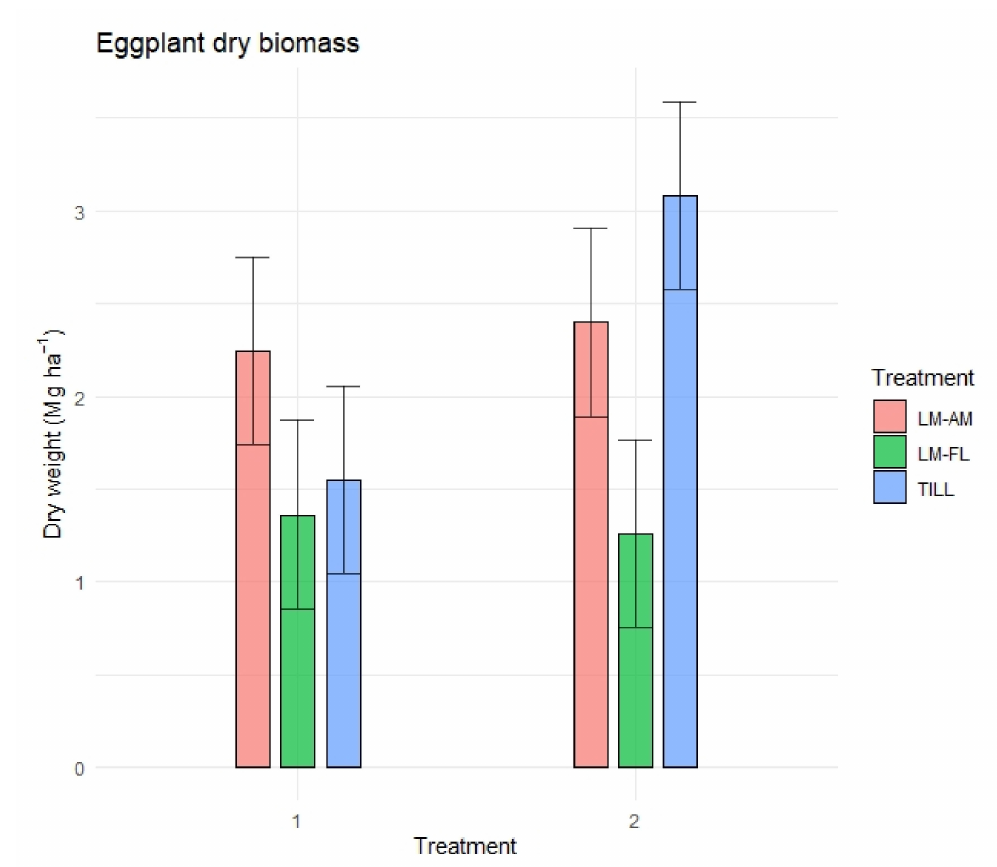
Figure 6. Effect of treatments (TILL, LM-FL, LM-AM) and years (1 is 2020, 2 is 2021) on egg- plant dry weight (stems and leaves). Error bar represents the upper and lower limits of the 95% confidence